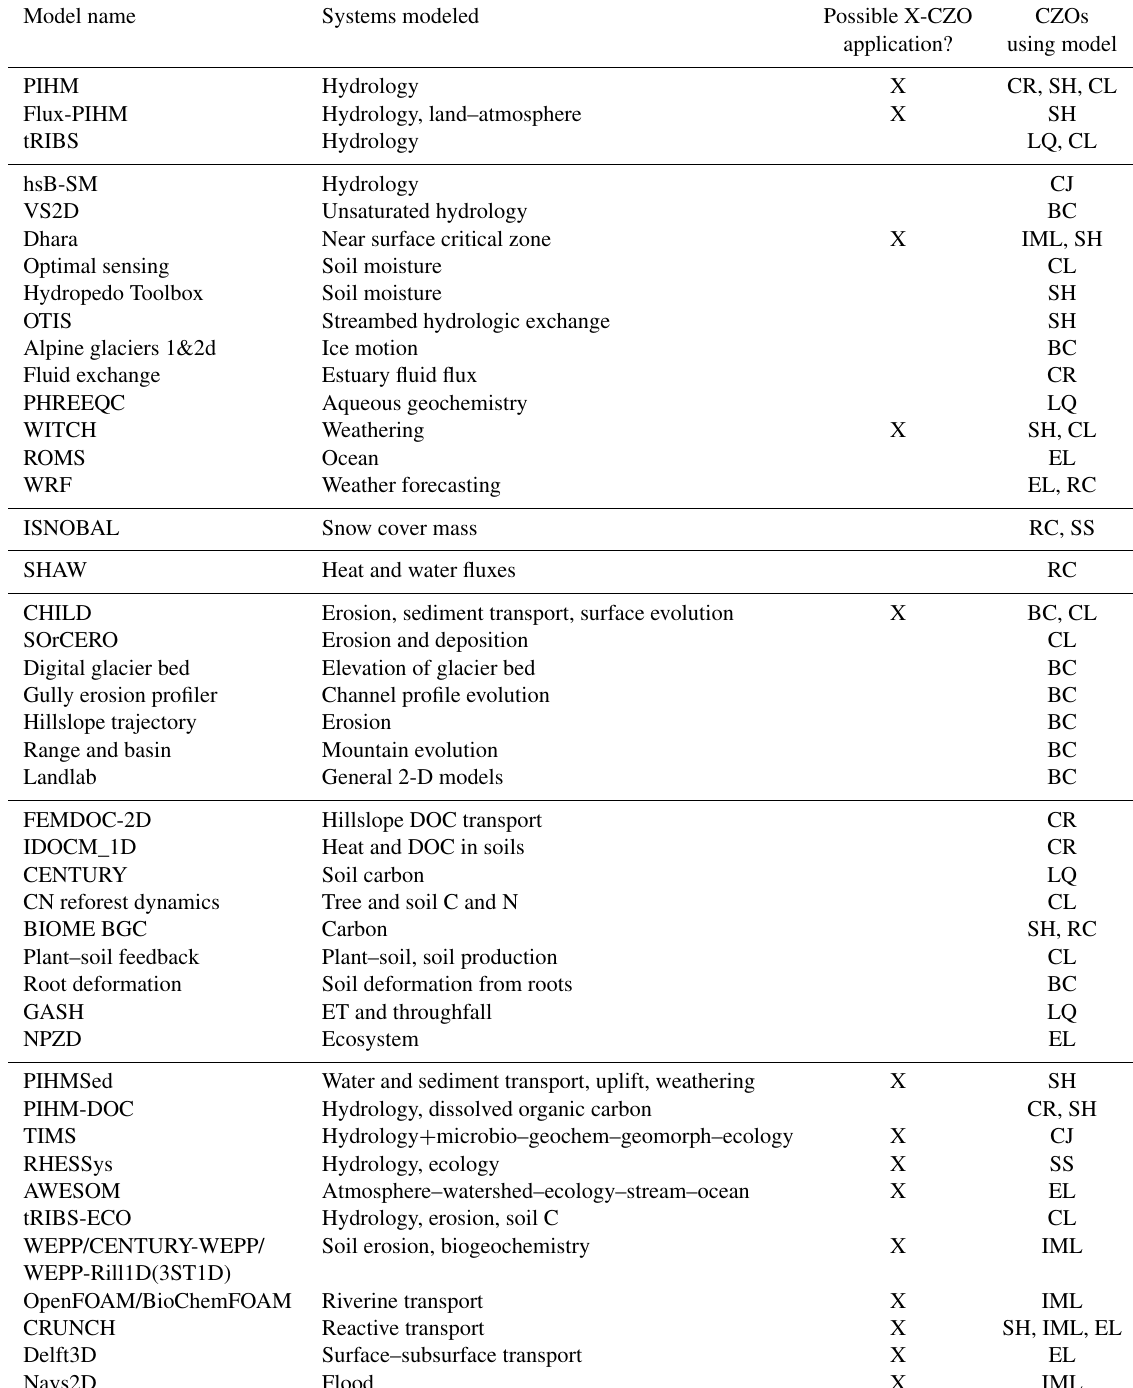
Table 3. Models used by the US CZOs (observatory abbreviations in Fig.